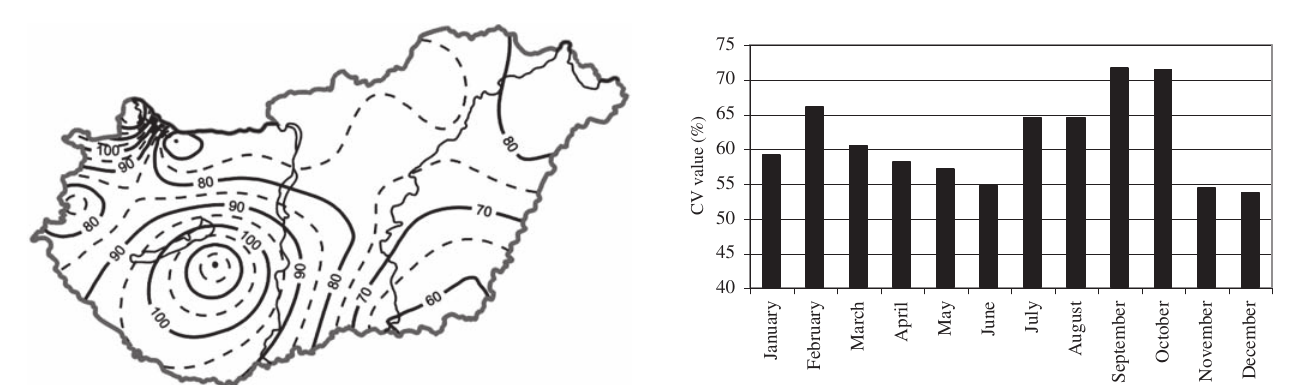
Figure 5 – The mean values of the coeffi cients of variation (CV) of monthly maxima of precipitation in 16 stations over a period of 1951–2010